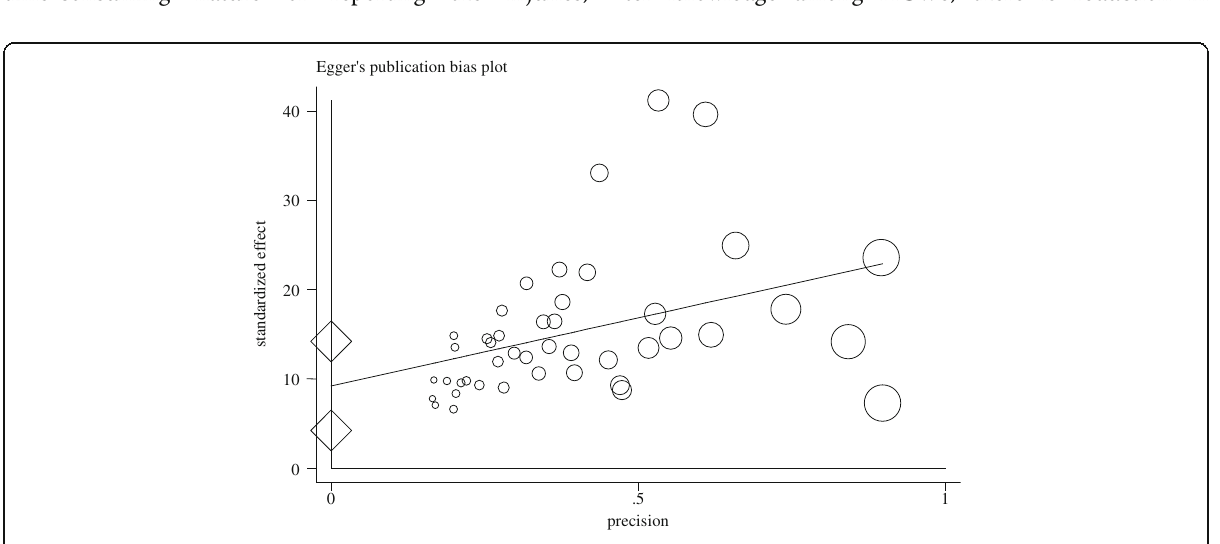
Fig. 5 Publication bias. This figure is used to investigate the publication bias of studies. Circles show selected studies, and the area of each circle is equivalent to the weight of each study. The horizontal axis represents accuracy, and the vertical axis represents the standardized effect. The line shown in this figure is a regression line related to Egger ’ s regression test. It shows that whether this line cut the vertical axis at the point near zero or not. If this line distance from zero, it indicates a bias in publishing the results. If there is no publication bias, it is expected that this line passes from origin to a point near the origin. Since intercept (width from origin) is close to 9 in this figure, we conclude that publication bias is significant. Two diamonds that are plotted on the vertical axis indicate confidence interval corresponds to the coefficient obtained from the regression test β _1 that it is 4.2 to 14.1. Because zero is not included in the confidence interval. Therefore, it could be concluded that the publication bias is